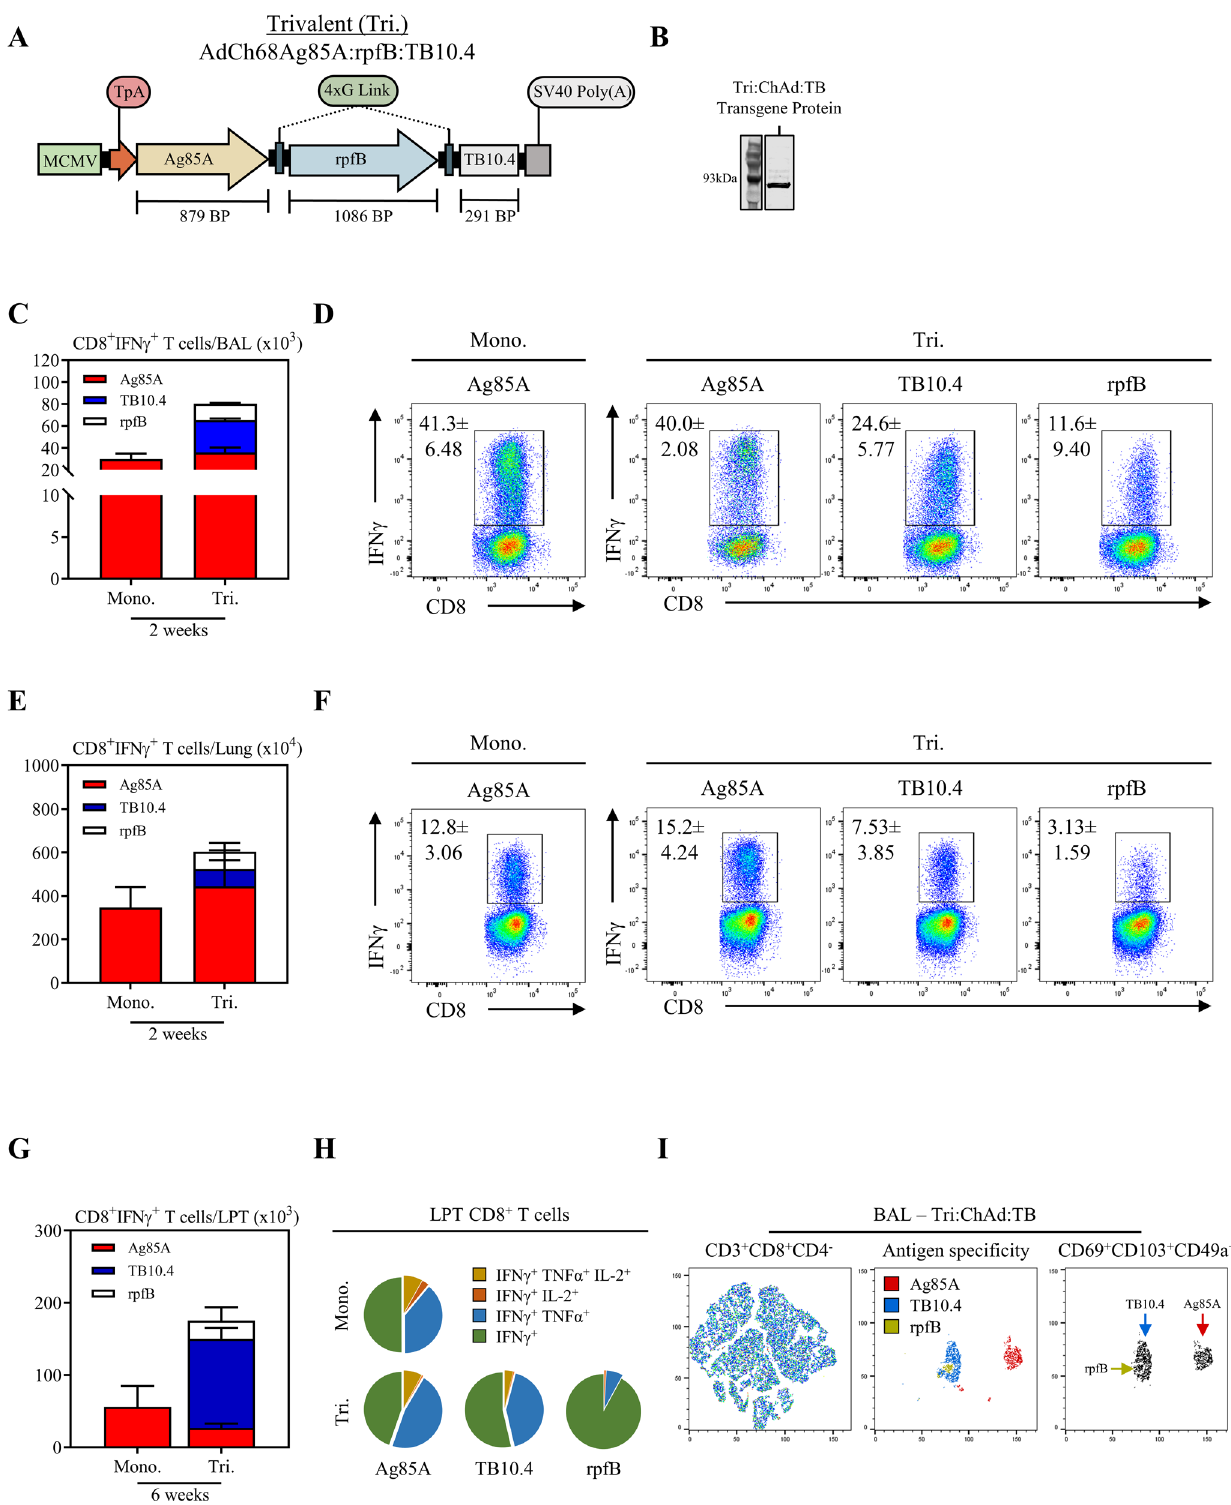
intranasally (i.n.) with a single dose of Tri:ChAd:TB (Tri). For comparison, a group of mice were i.n. immunized with an equal dose of its monovalent counterpart, Mono:ChAd:TB (Mono). T-cell responses were analyzed in the airway lumen, represented